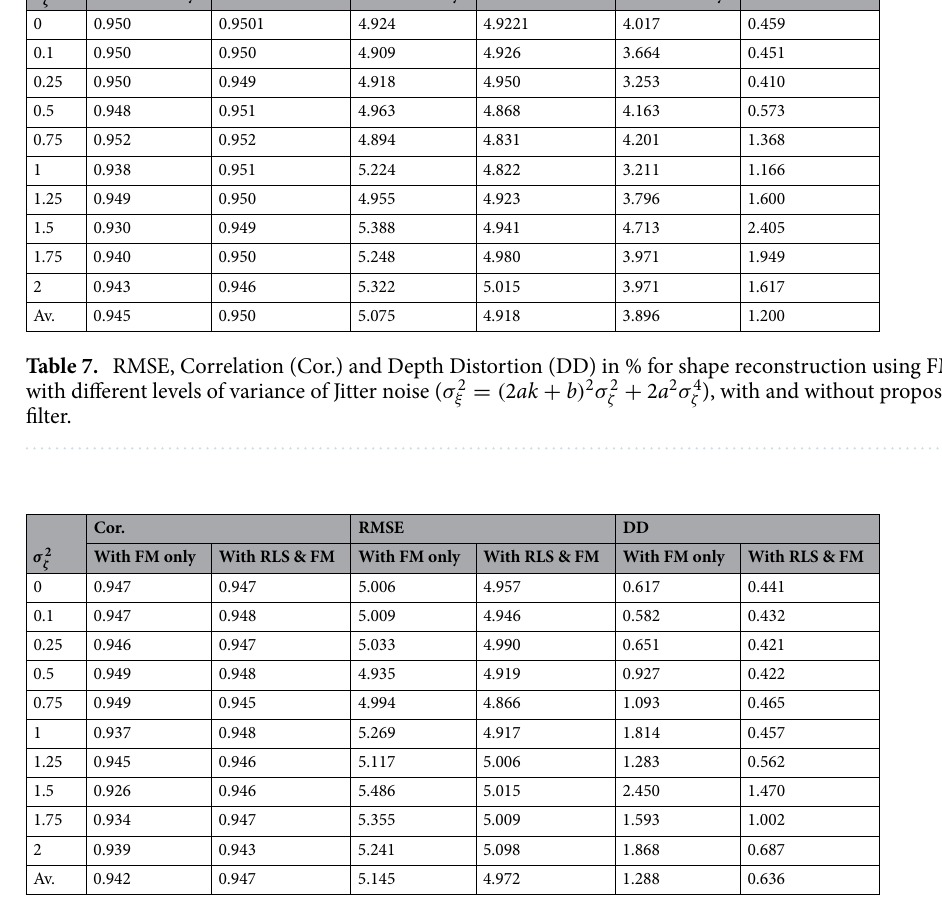
Table 8. RMSE, Correlation (Cor.) and Depth Distortion (DD) in % for shape reconstruction using FM:SFRQ with different levels of variance of Jitter noise ( σ 2 ξ = ( 2 ak + b ) 2 σ 2 ζ + 2 a 2 σ 4 ζ ), with and without proposed RLS filter.